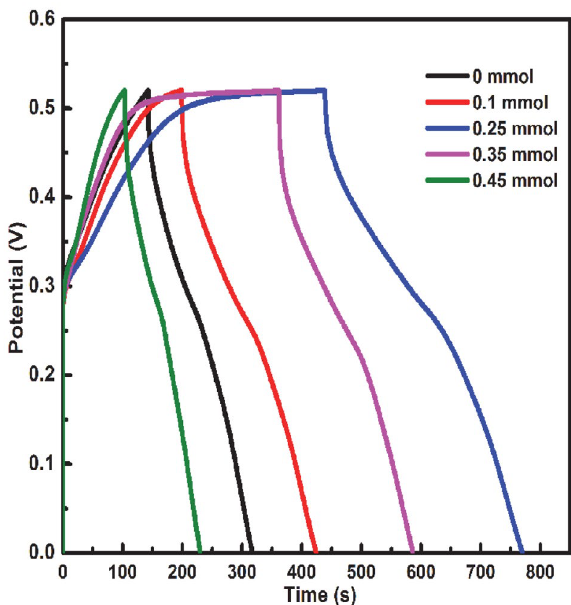
Fig. 6. Galvanostatic charge-discharge curves of as-prepared elec- trodes at a current density of 1 A g –1